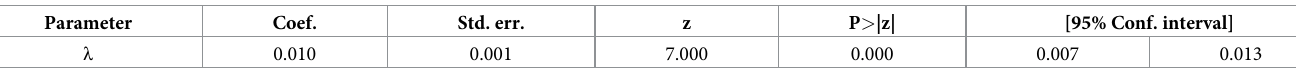
Table 3. The parameter of λ in the classical-exponential model for the excavator’s failure data. Parameter Coef. Std. err. z P > |z| [95% Conf. interval] λ 0.010